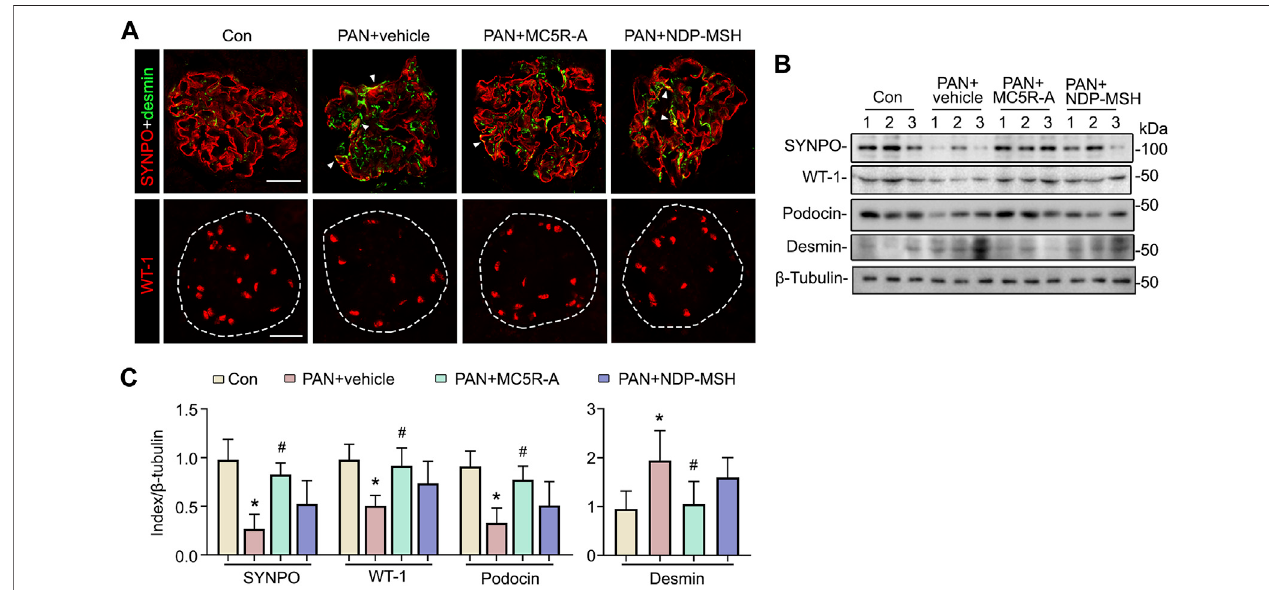
FIGURE 3 | MC5R agonist exerts a protective effect on glomerular injury and podocytopathy in PAN nephrosis rats. (A) Animals were treated as elaborated in Figure 2 . Cryosections of kidney tissues procured from various groups were subjected to immuno fl uorescence staining for the podocyte-speci fi c markers, including synaptopodin (SYNPO) and WT-1, as well as for desmin, a marker of podocyte injury. Representative micrographs are shown (Scale bar = 50 μ m). White arrowheads indicate yellow signals positive for both SYNPO (red) and desmin (green), denoting de novo expression of desmin in podocytes. (B) Isolated glomeruli were processed for immunoblot analysis for SYNPO, WT-1, podocin, desmin, as well as β -tubulin, which served as the loading control. (C) Quanti fi cation of the indicated protein expression levels by densitometric analyses of immunoblots, expressed as relative levels normalized to β -tubulin. p p < 0.05 versus the same index expression of control (Con) group; # p < 0.05 versus the same index expression of PAN + vehicle group ( n = 6).